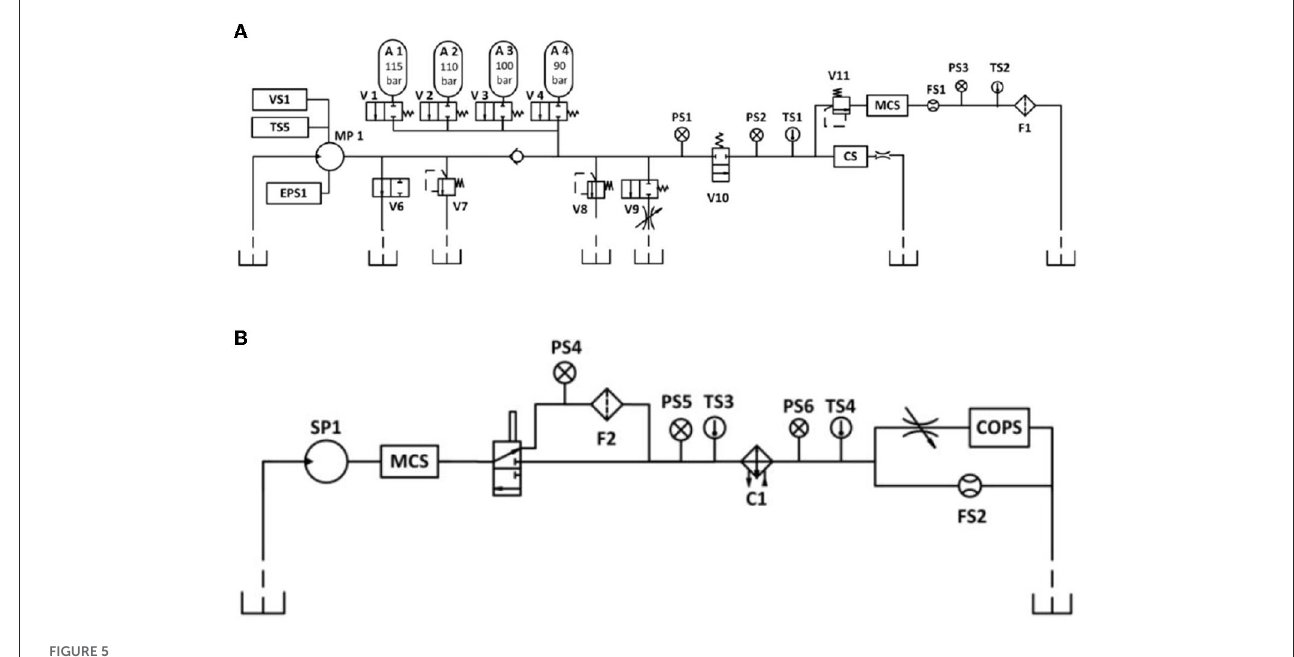
FIGURE5 (A, B) Hydraulic systems.